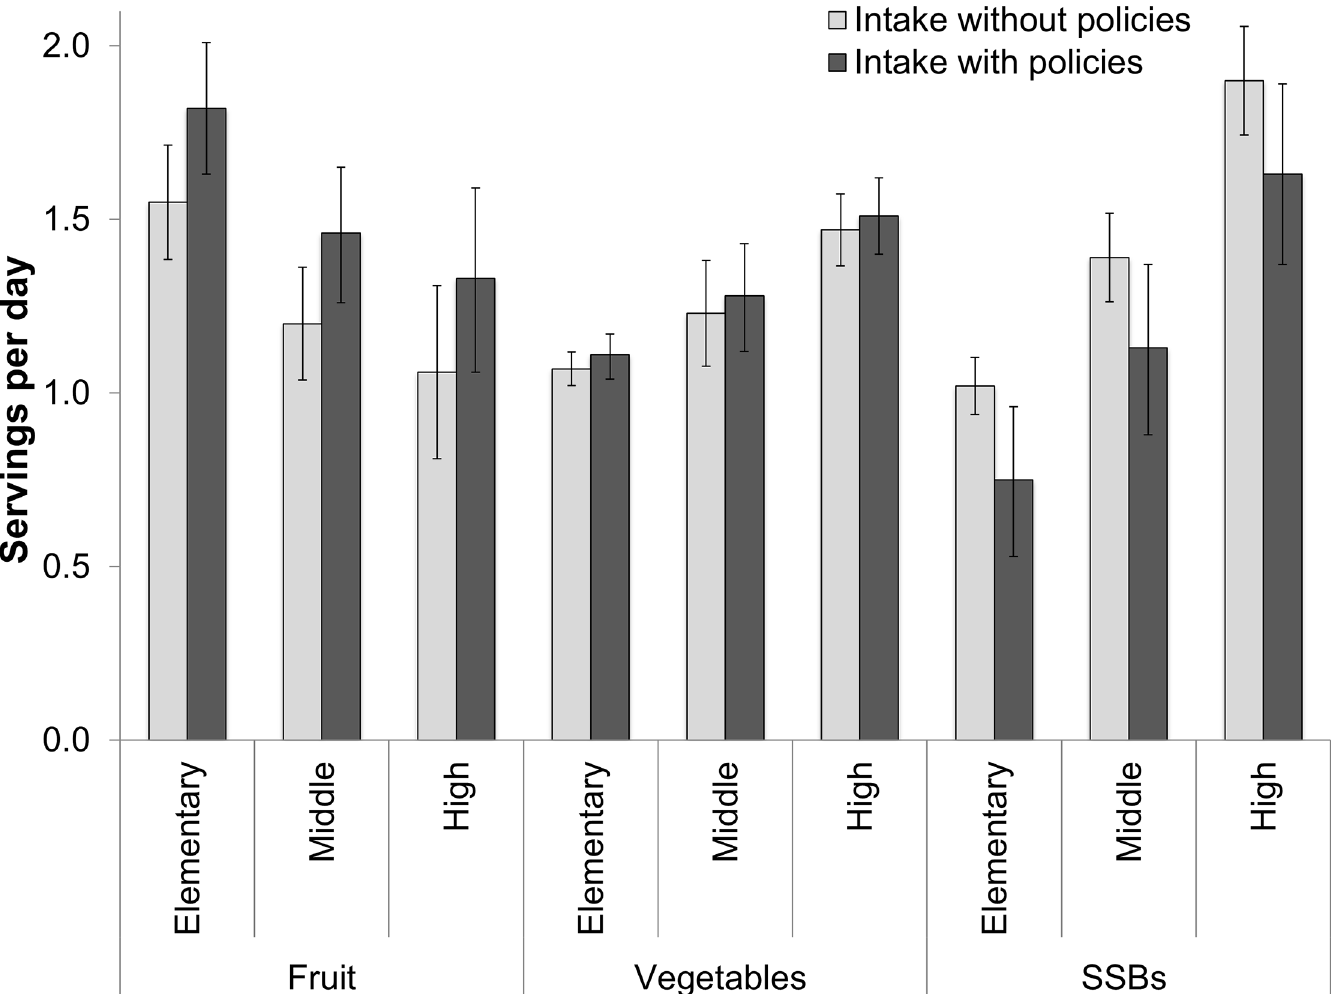
Fig 1. Current and estimated changes in dietary intakes associated with national school policies on F&V provision and SSB restriction among US children by age. Current intakes are based on NHANES 2009–10 and 2011–12 (N = 4,165 children age 5–18 years), where bars represent the mean and error bars, the 95% confidence intervals. Estimates for dietary intake with policies are based on a comparative risk assessment framework incorporating policy effects from intervention studies, where bars represent the median values from 1,000 Monte Carlo simulations and error bars, the 95% uncertainty intervals.